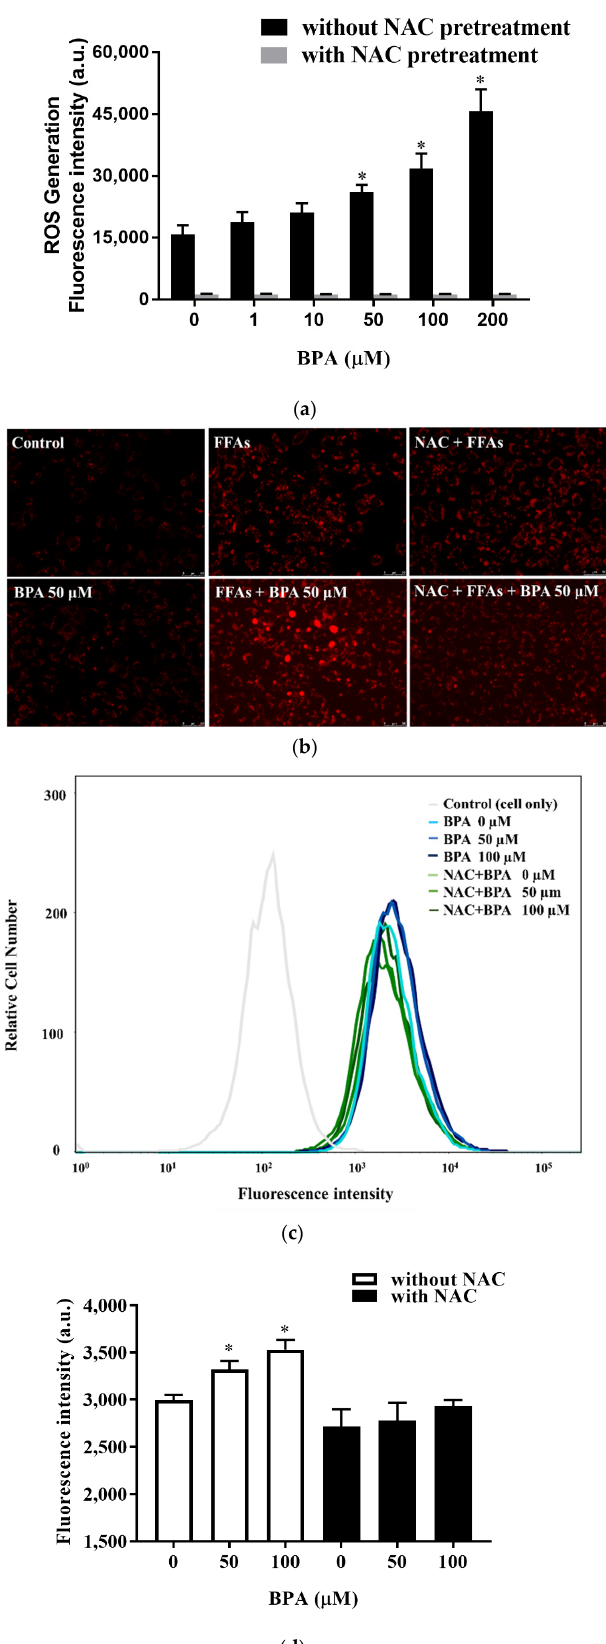
Figure 3. Regulation of ROS levels ameliorated BPA-induced fatty acid uptake and lipid droplet deposition in HUH-7 cells: ( a ) Cells were pretreated with 2 ′ , 7 ′ -dichlorofluorescin diacetate and NAC (3 mM) for 45 min, before being loaded with the indicated concentrations of BPA for 6 h. Intracellular ROS levels were determined based on fluorescence intensity; ( b ) cells were treated with BPA after pretreatment with FFAs (0.5 mM) or NAC (3 mM). The accumulation of lipid droplets was assessed using AdipoRed staining; ( c ) fatty acid uptake was determined using flow cytometry after exposure to BPA (50 µM) for 6 h, in the absence or presence of NAC pretreatment; ( d ) the mean of the fluorescence intensity results (bottom right). The results are expressed as the mean ± SD of six independent experiments. * p < 0.05 vs. control (without BPA and NAC) group. 3.4. BPA Induced Fatty Acid Uptake by Modulating CD36 Expression BPA exposure caused a significant increase in the mRNA and protein expression lev- els of CD36, but did not affect the expression of SR-A1 or SR-B1 (Figures 4a,b and S1a,b). We assessed whether NAC could prevent BPA-induced ROS production and ER stress. Results showed that the expression of CHOP decreased in cells pretreated with NAC (Fig- ures 4c and S2a,b). In addition, NAC pretreatment attenuated the BPA-induced expres- sion of CD36 and CCAAT-enhancer-binding protein α (C/EBP α ). These results confirm the direct effect of BPA-induced ROS production on intracellular fatty acid uptake.